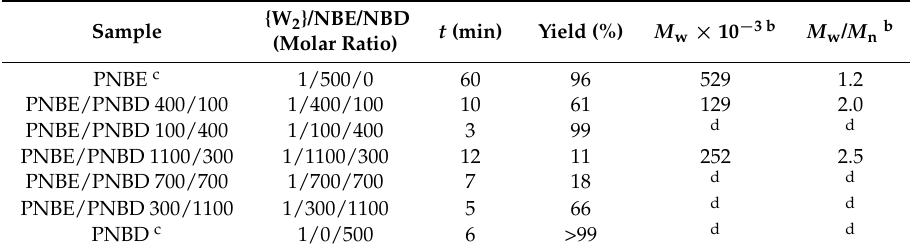
Table 1. Reactions of {W 2 } with NBE and NBD a .